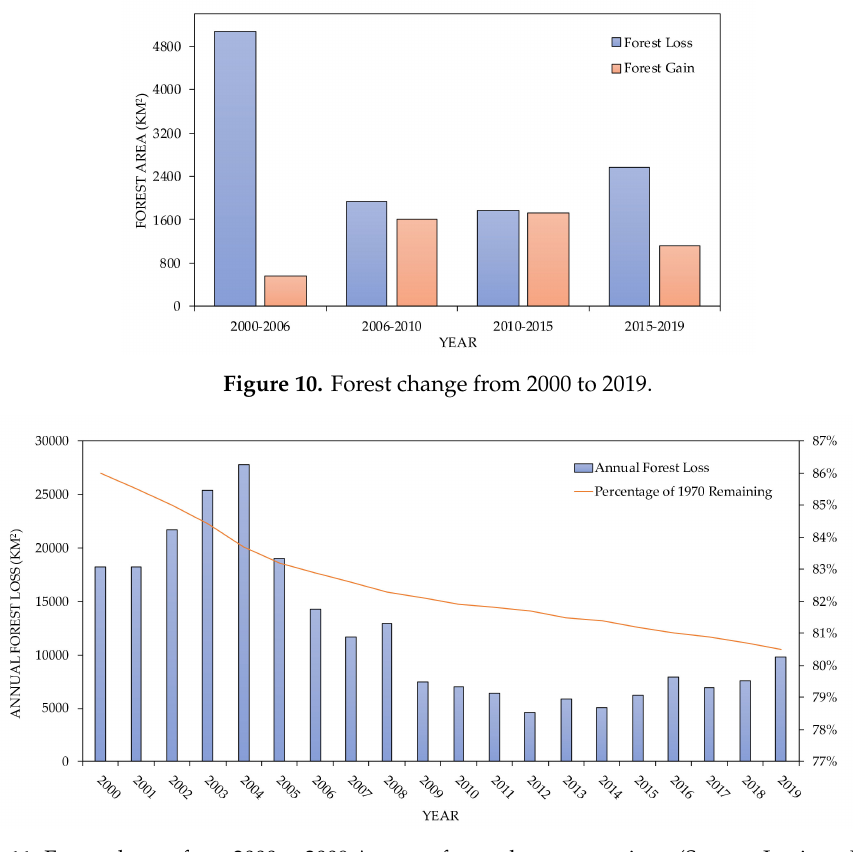
Figure 11. Forest change from 2000 to 2009 Amazon forest change over time. (Source: Instituto Nacional de Pesquisas